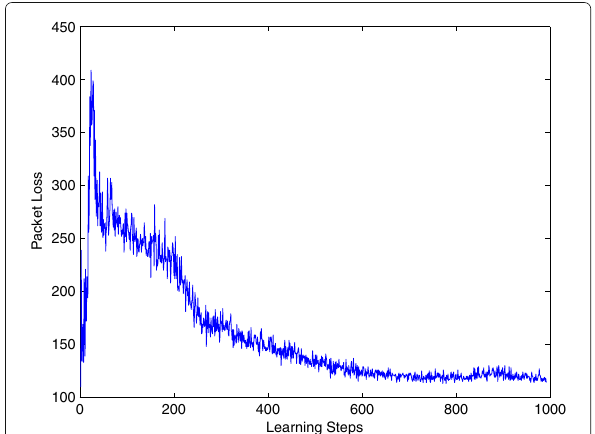
Fig. 12 Packet losses versus learning steps